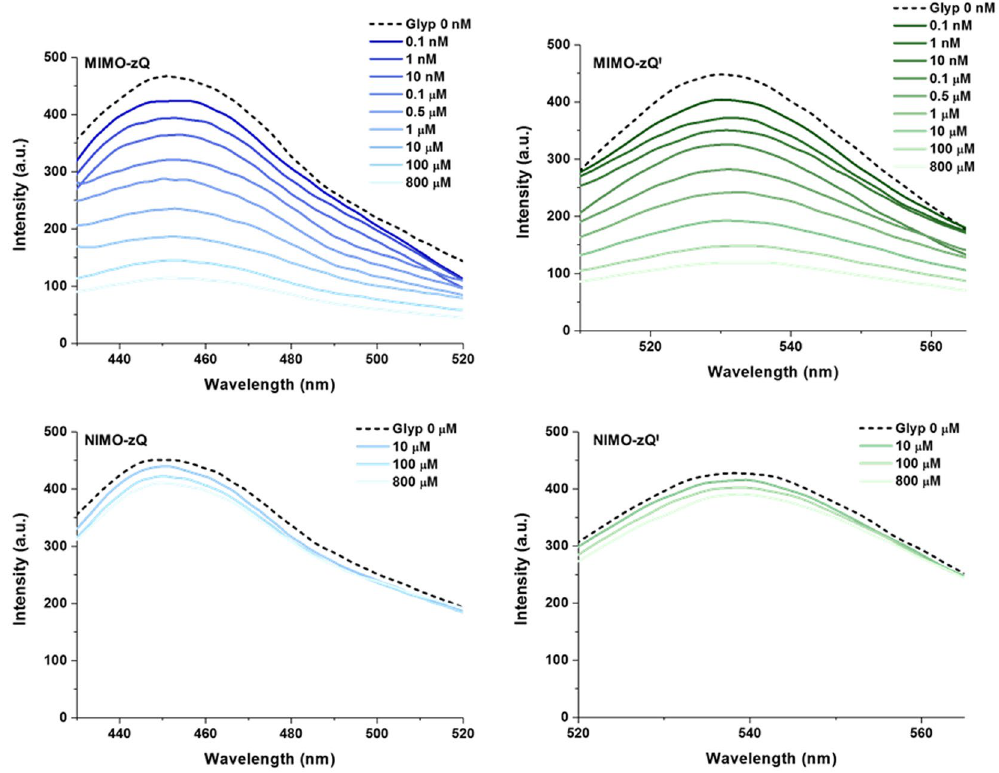
Figure 3. Photoluminescence (PL) emission as a function of the analyte concentration: PL spectra of graphene QD and InP/ZnS QD incorporated MIMO-z (MIMO-zQ and MIMO-zQ’). Also shown are the PL spectra of graphene QD and InP/ZnS QD incorporated NIMO-z (NIMO-zQ and NIMO-zQ’), which represent the absence of imprinted binding sites.